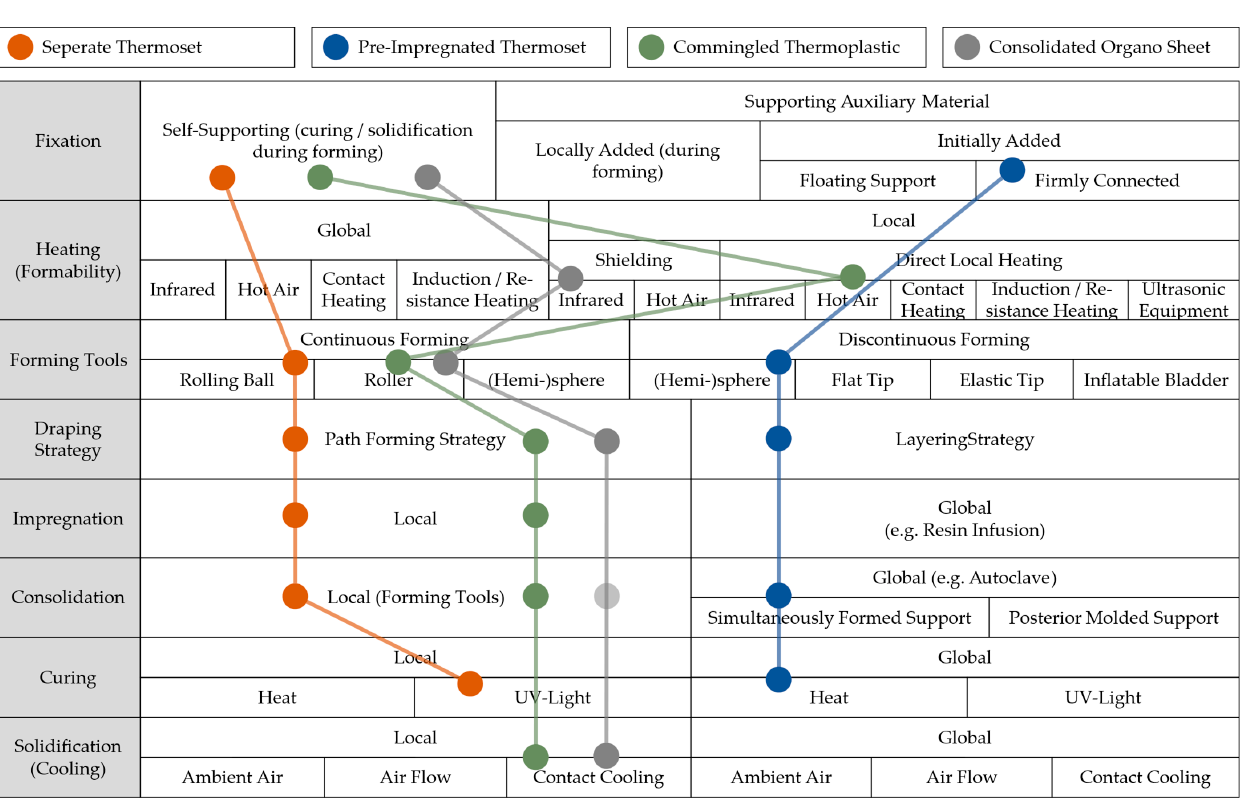
Figure 10. Morphological box with possible processing routes for the most feasible material types.